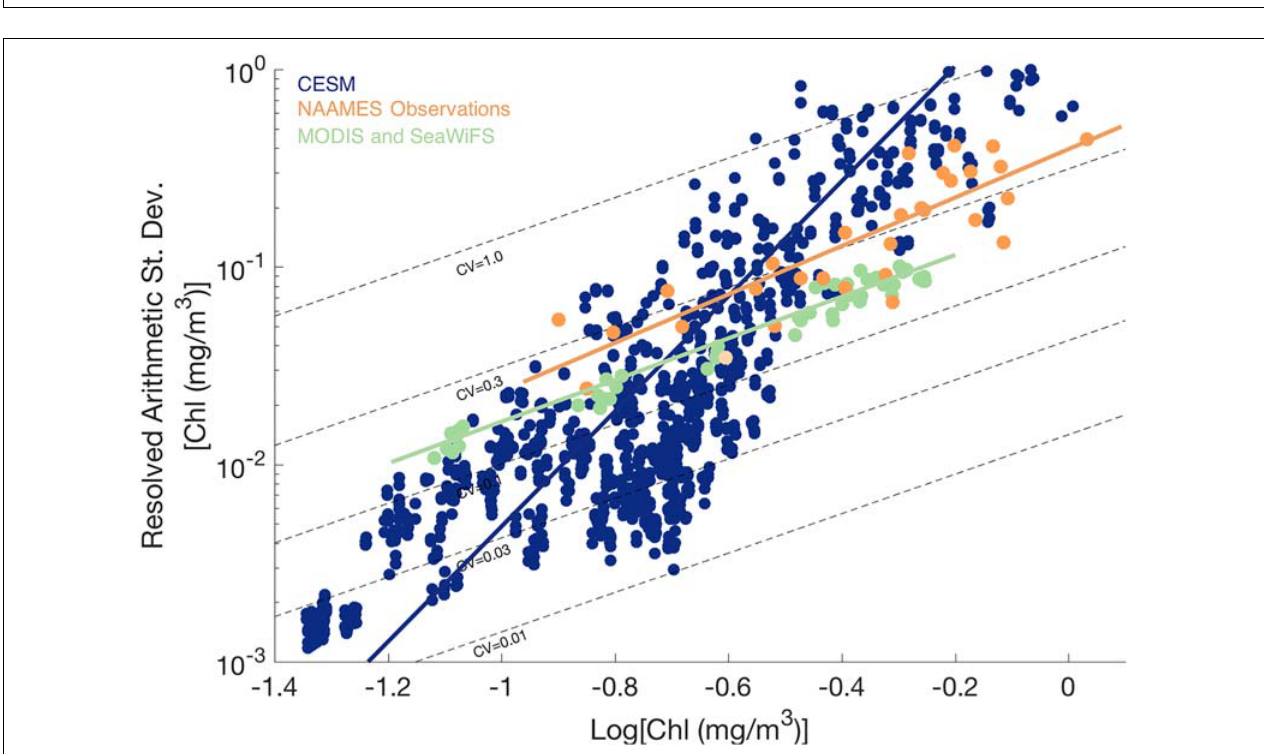
FIGURE 4 | Geostatistical analysis of annual average surface chlorophyll a resolved variability as computed in Eq. 2 (sill, top) and range (bottom) from CESM, MODIS, and SeaWiFS in 5 ◦ × 5 ◦ grid boxes.